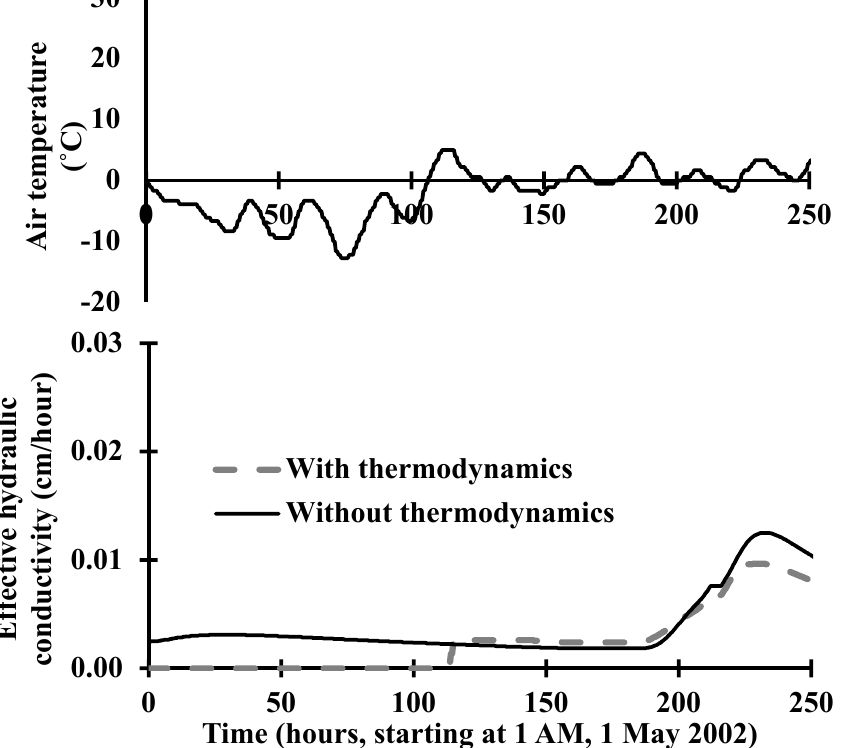
Figure 7. Hydraulic conductivity under freezing and thawing soil active layer.